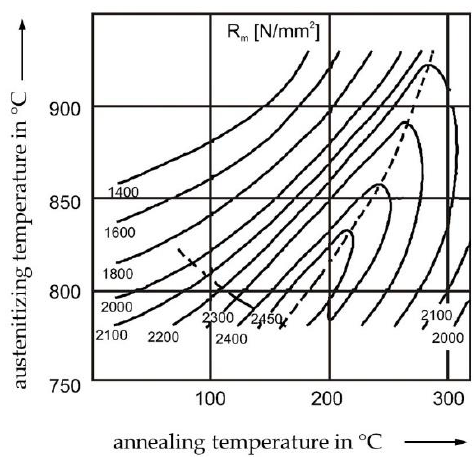
Figure 2. Lines of equal tensile strength R m determined in conventional tensile tests in dependence of austenitizing and annealing temperatures according to [19].